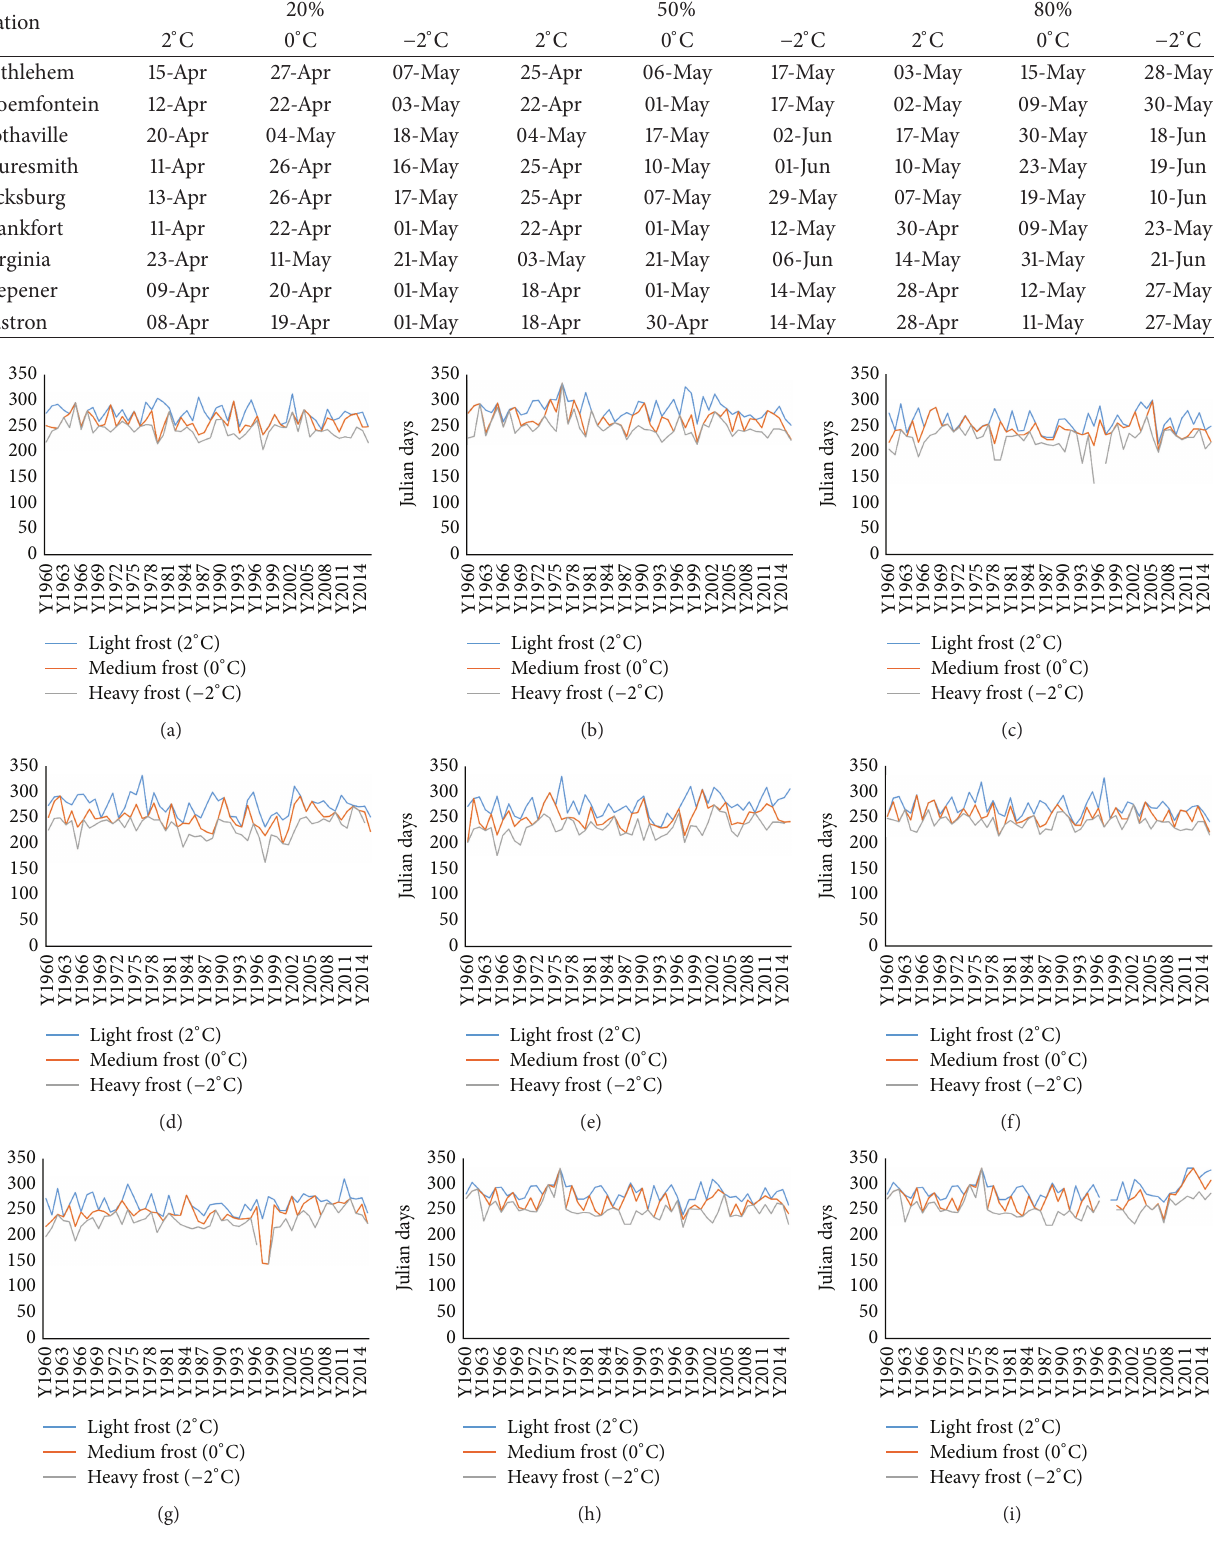
Table 4: Onset of frost at different probability levels (20%, 50%, and 80%) and thresholds (2 ∘ C, 0 ∘ C, and − 2 ∘ C).